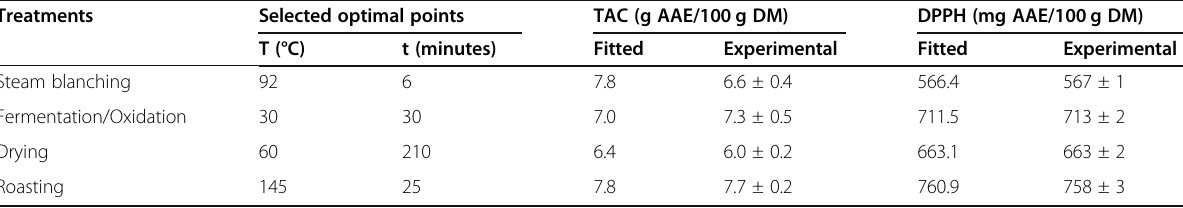
Table 5 Fitted and experimental responses at selected optimal points